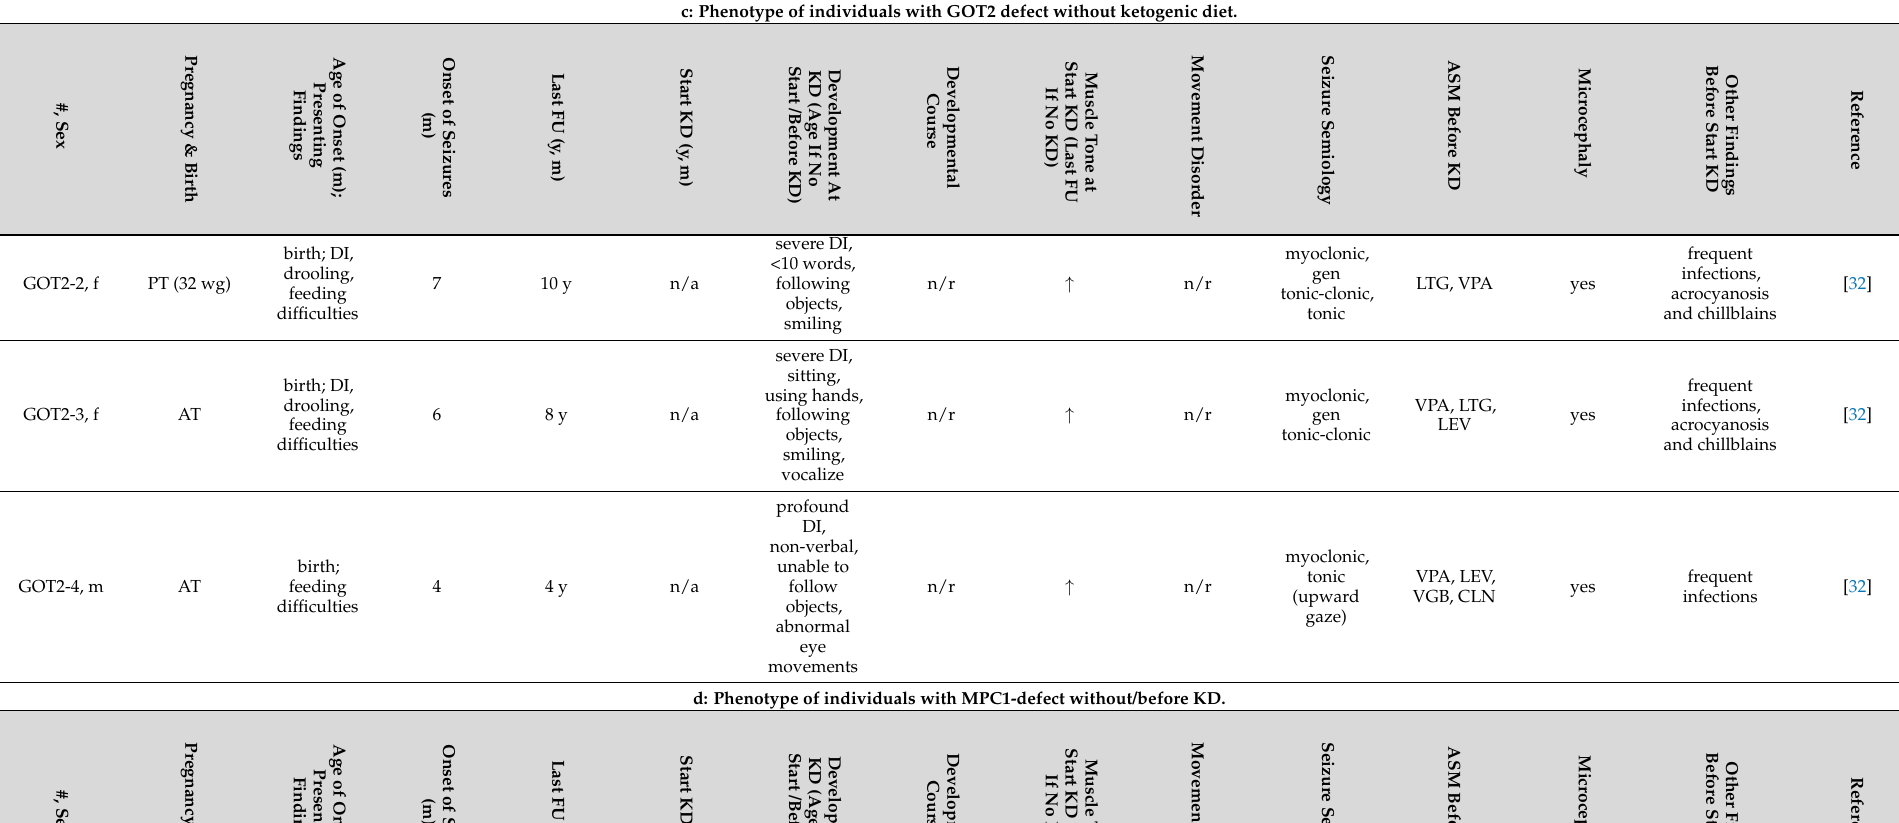
c: Phenotype of individuals with GOT2 defect without ketogenic